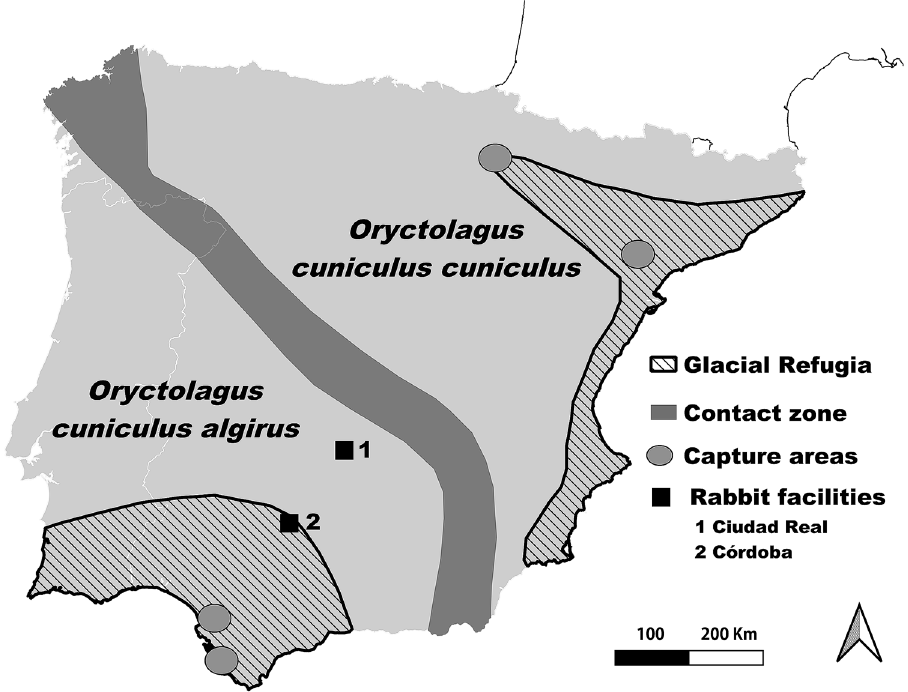
Figure 1. Distribution areas of Oryctolagus cuniculus algirus and O. c. cuniculus in the Iberian Peninsula and their contact zone 22 . Putative glacial refugia of European rabbit lineages described by Branco et al. 20 is shown. Black squares indicate the experimental facilities’ locations where rabbits were kept in captivity at Ciudad Real (1) and Córdoba (2). Ellipses indicate the areas where initial stocks of wild rabbits for the facilities were